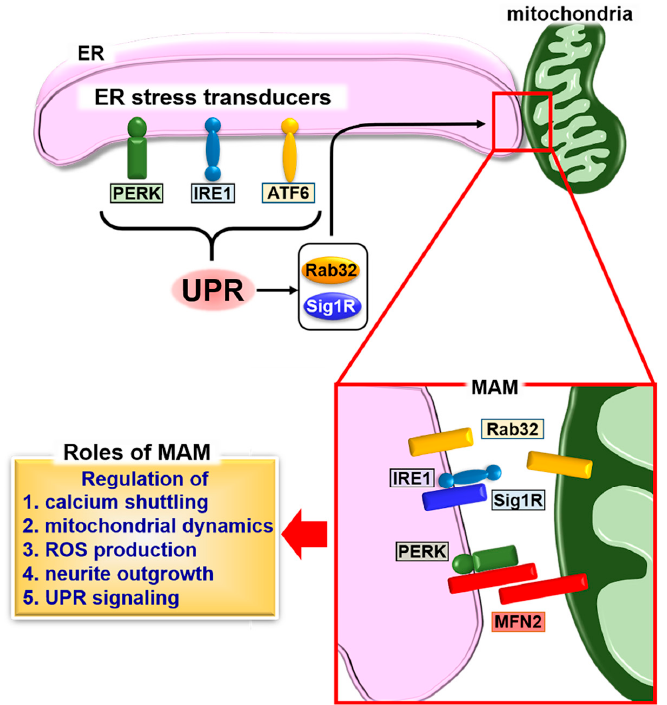
Figure 1. Schematic describing the formation of mitochondria-associated endoplasmic reticulum (ER) membrane (MAM) and the unfolded protein response (UPR). The UPR induces the expression of MAM connectors, Rab32 and sigma 1 receptor (Sig1R), followed by fine-tuning of calcium signaling, calcium shuttling, mitochondrial dynamics, reactive oxygen species (ROS) production, and neurite outgrowth through the formation of MAM. The stability of inositol-requiring kinase 1 (IRE1) is regulated by Sig1R binding. The binding of Sig1R to IRE1 leads to long-lasting activation of IRE1, which promotes cellular survival under ER stress conditions. A second MAM connector, mitofusin 2 (MFN2), interacts with protein kinase R-like ER kinase (PERK) to inhibit its activity for regulating ROS production, calcium shuttling, and mitochondrial morphology.